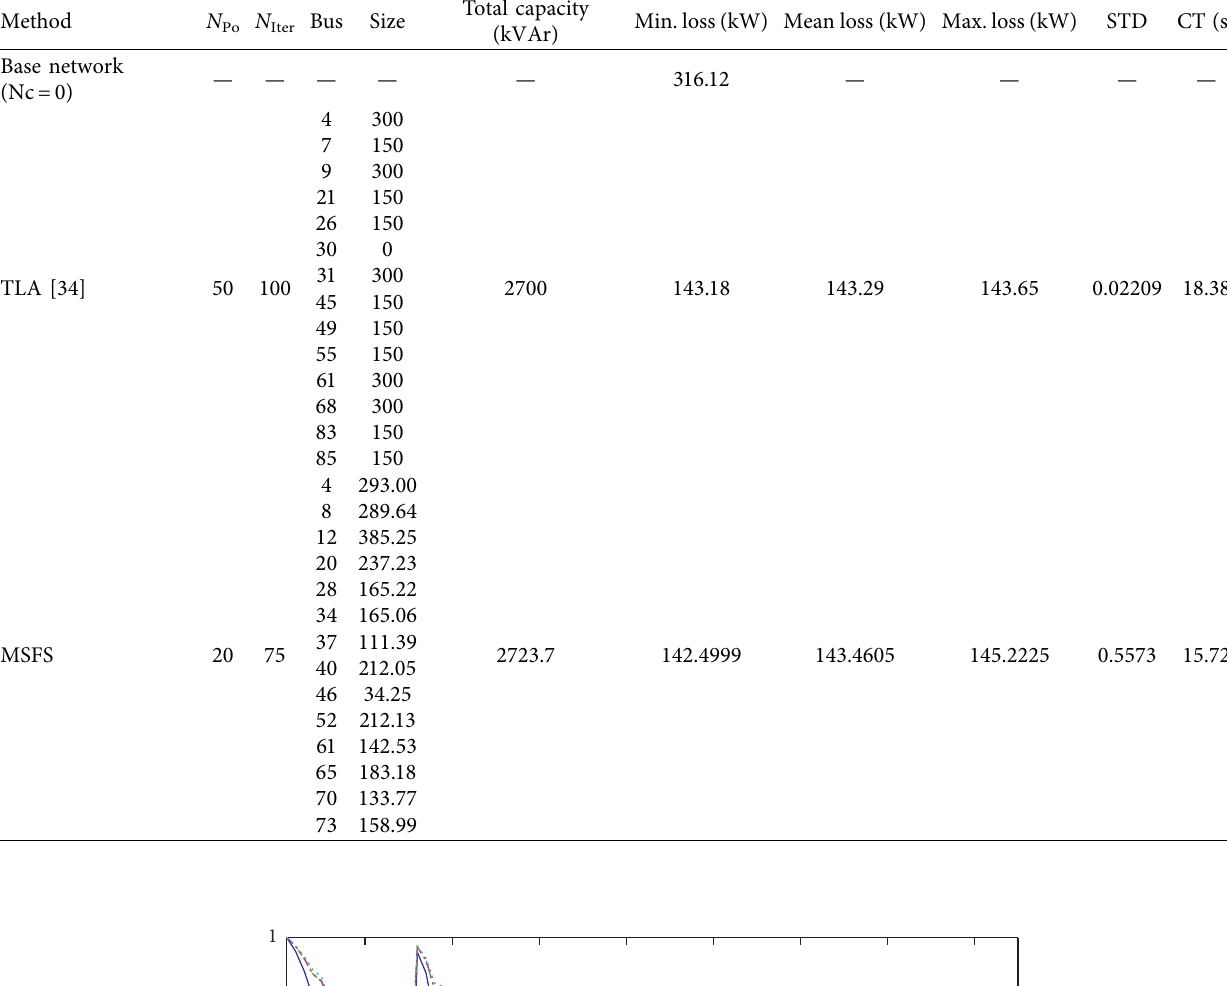
Table 10: Comparison with other methods for case 4 of the 85-bus system.